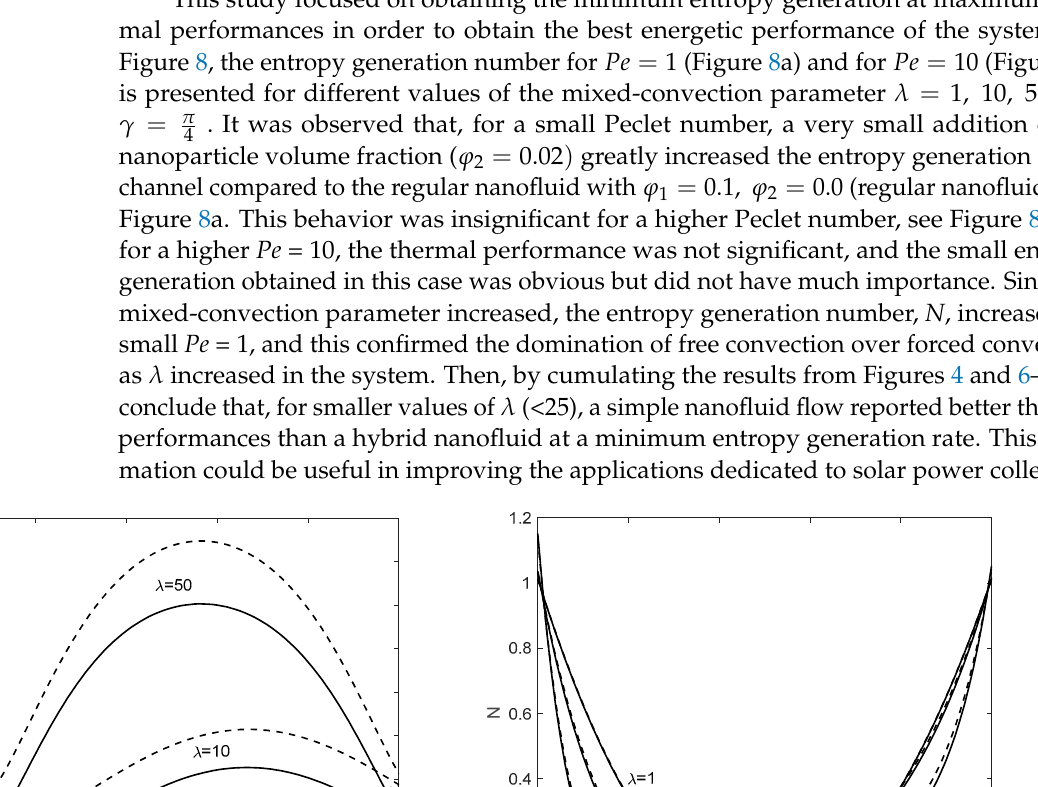
= 0.1, 𝜑 = 0.0 (regular nanofluid) and with a broken (cid:2869) (cid:2870)